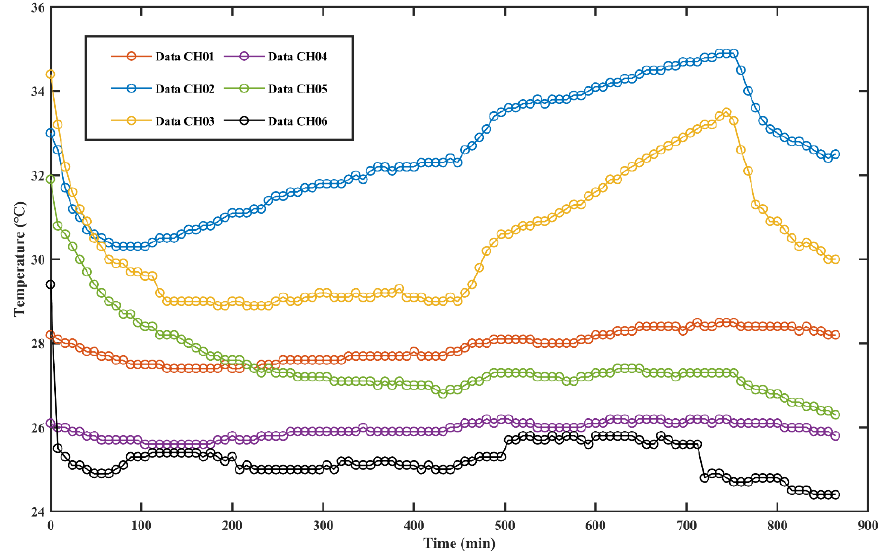
Figure 15. Temperature vs. time curves of sensor nodes at seaside shoal.